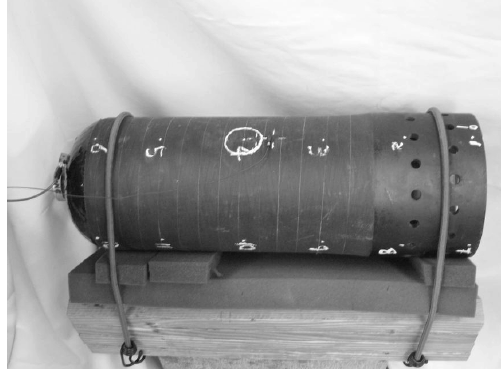
Fig. 18. Filament-wound RMC in test fixture for the drop-tower